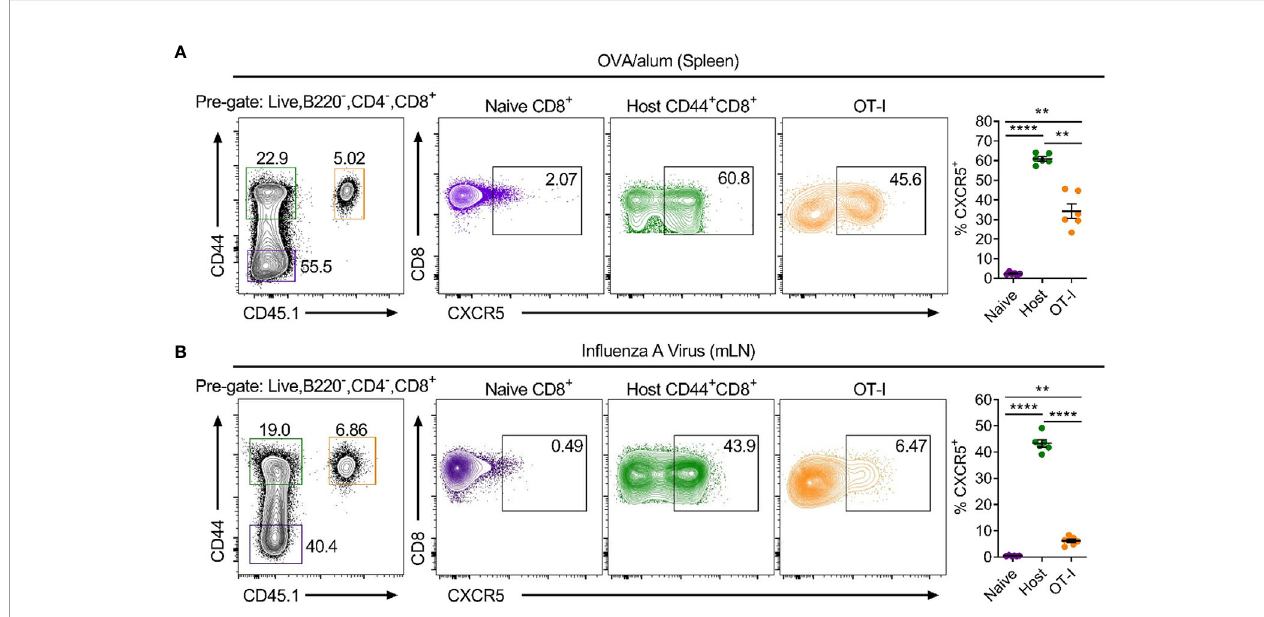
FIGURE 1 | CXCR5 + CD8 + T cells are generated in acute settings in the absence of follicular infection following protein immunisation and IAV challenge. Isolated, congenically marked (CD45.1/2) OT-I cells were transferred i.v into C57BL/6 mice that were then (A) immunised with OVA/alum intraperitoneally or (B) infected with x31-OVA intranasally. Flow cytometry of (A) spleen cells on day 7 post-immunisation with OVA/alum and (B) mLN cells on day 8 post-infection with x31-OVA, assessing CXCR5 expression on the indicated cell populations. Data are representative of at least three independent experiments with at least 4 mice. Data were analysed by a repeated measures one-way ANOVA. Mean ± SEM. **p < 0.01, ****p <